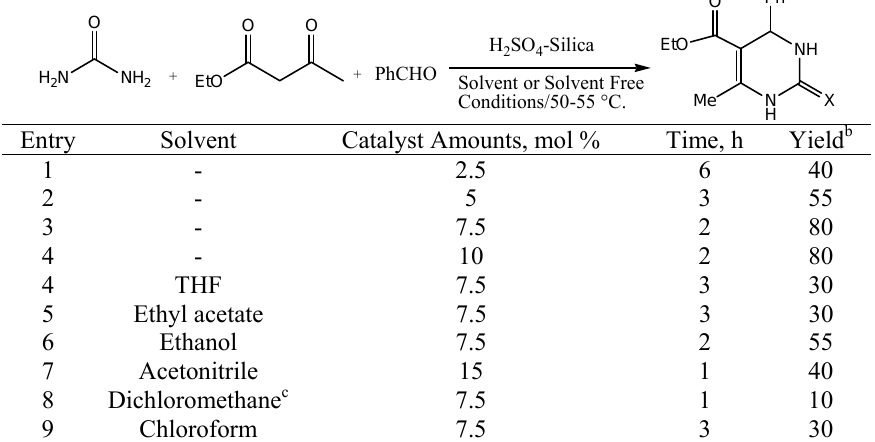
SO –Silica on the yield of the DHPMs a 2 4